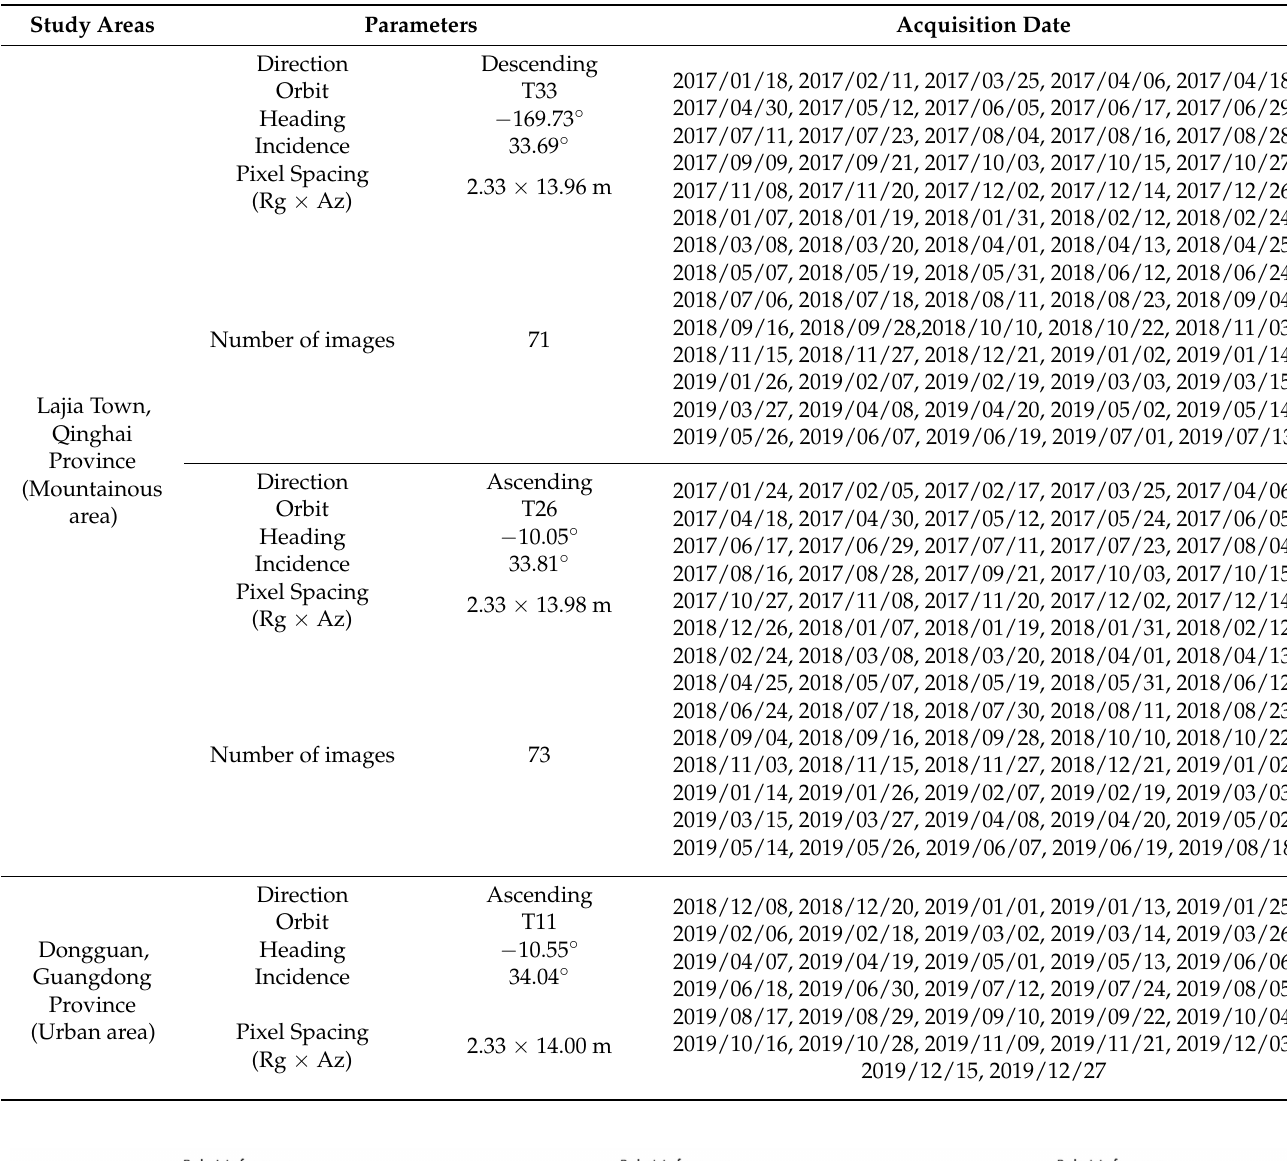
Table A1. Parameters and acquisition dates of the images used in this study.